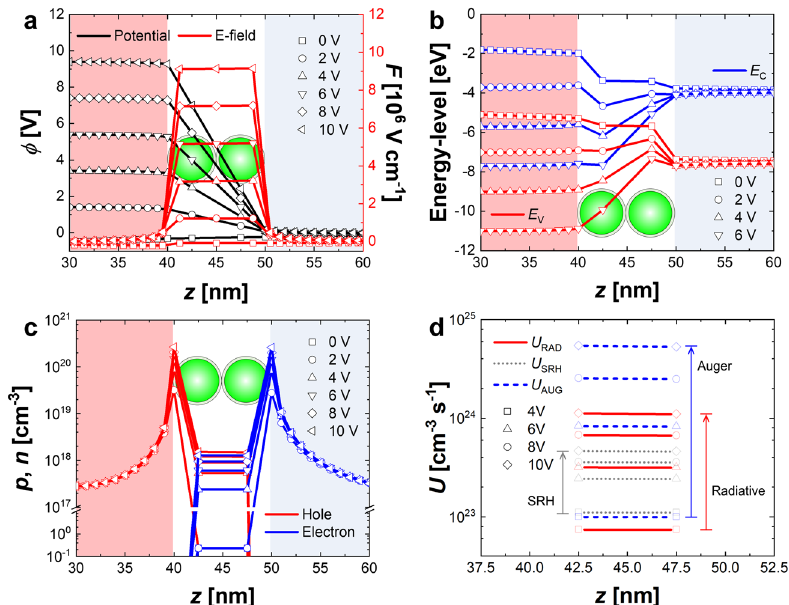
Fig. 2 Internal distributions of physical quantities across the QD-LED device under applied voltages from 0 V to 10 V for every 2 V steps. a Potential and electric fi eld distributions. b Steady-state energy-level distributions of conduction and valance band around the EML. c Distributions of the hole and electron densities around the EML. d Radiative, SRH and Auger recombination rates at each QD layers. Here, the number of QD layers M is 2 and the diameter of the QD is 5 nm. The bandgap of the QD core is 2.28 eV for the light wavelength of 545 nm. The LUMO and the HOMO levels of the QD core are − 3.66 eV and − 5.94 eV so that Δ E C0 = Δ E V0 = 0.34 eV, and the charge injection mobilities of hole and electron, α p and α n , are both 3.0 × 10 − 9 cm 2 V − 1 s − 1 to balance the holes and electrons accumulated in QD